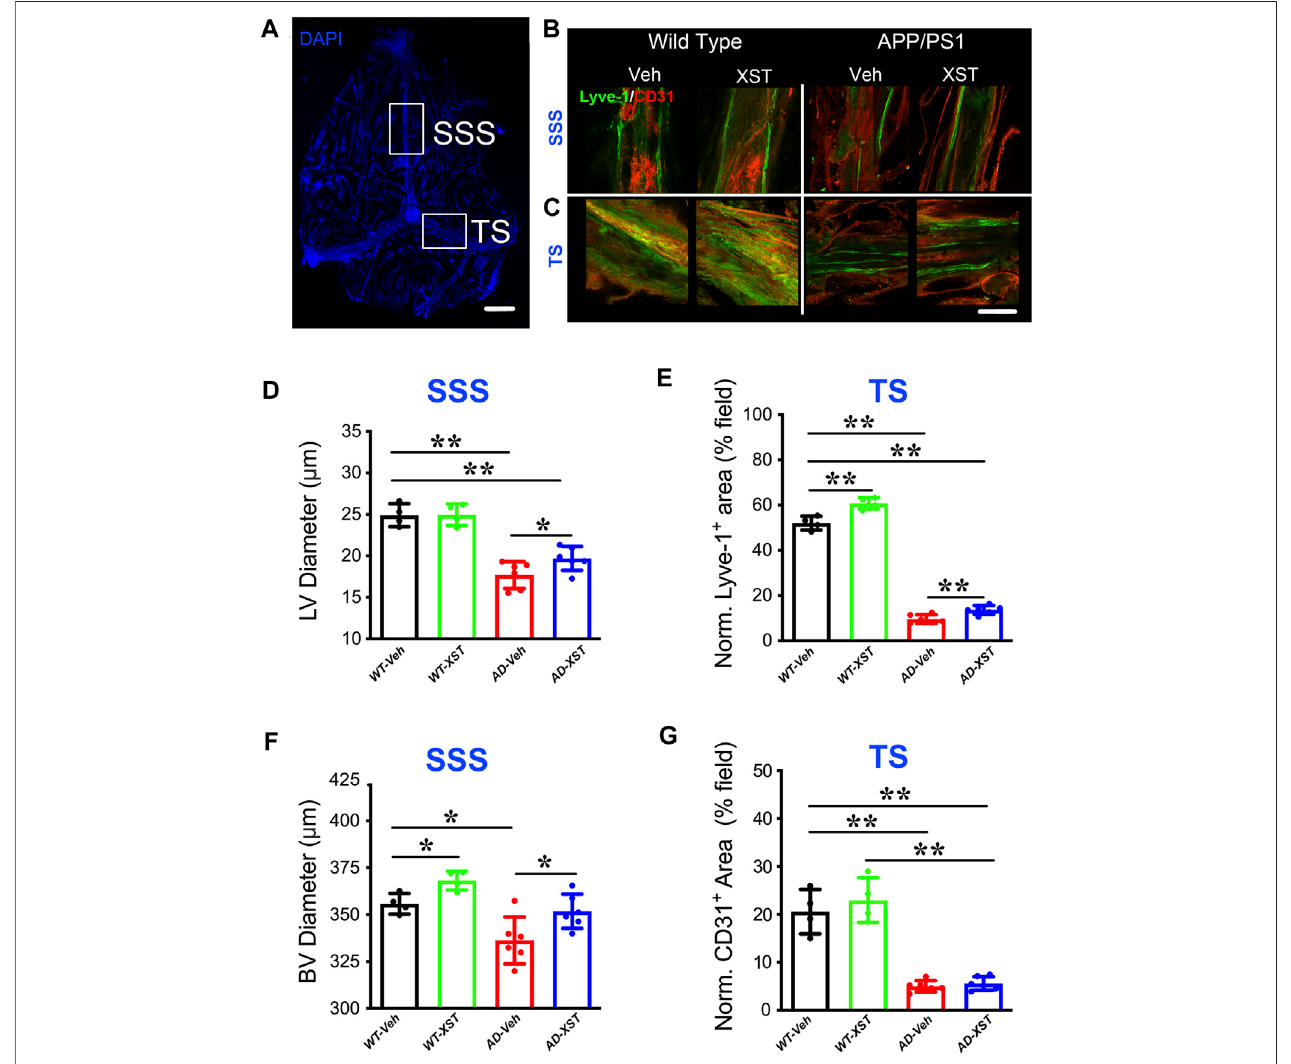
FIGURE1| EffectsofXSTonlymphaticstructures. (A) Schematicrepresentationofthewhole-mountdissectionoftheduramater.SSS,superiorsagittalsinus;TS, transverse sinus. Scale bar, 2,000 μ m. (B) Sample images of lymphatic vessels (LVs) (Lyve-1) and blood vessels (BVs) (CD31) in the SSS region, in wild-type and APP/ PS1micetreatedwitheitherXSTorVehicle(Veh).C57-Veh( n (cid:2) 4mice),C57-XST( n (cid:2) 4mice),AD-Veh( n (cid:2) 6mice),AD-XST( n (cid:2) 6mice).Scalebar,200 μ m. (C) Sample images of lymphatic ducts (Lyve-1) and BVs (CD31) in the TS region, in wild-type and APP/PS1 mice treated with either XST or Veh. Scale bar, 200 μ m. (D) Quanti fi cation of the diameter of lymphatic ducts in mice treated with XST or Veh in the SSS region (F (1, 16) (cid:2) 87.18, C57 vs. AD, p < 0.0001; AD-Veh vs. AD-XST, p (cid:2) 0.034, two-way ANOVA with Bonferroni ’ s multiple comparisons). (E) Quanti fi cation of the area occupied by lymphatic ducts in mice treated with XST or Veh in the TS region (F (1, 16) (cid:2) 36.92, C57 vs. AD, p < 0.0001; C57-Veh vs. C57-XST, p < 0.001; AD-Veh vs. AD-XST, p (cid:2) 0.0454, two-way ANOVA with Bonferroni ’ s multiple comparisons). (F) Quanti fi cationofthediameterofBVsinmicetreatedwithXSTorVehintheSSSregion(F (1,16) (cid:2) 22.18,C57vs.AD, p (cid:2) 0.0002;C57-Vehvs.C57-XST, p (cid:2) 0.049;AD-Vehvs.AD-XST, p (cid:2) 0.0303,two-wayANOVAwithBonferroni ’ smultiplecomparisons). (G) Quanti fi cationoftheareaoccupiedbyBVsinmicetreatedwith XST or Veh in the TS region (F (1, 16) (cid:2) 141.4, C57 vs. AD, p < 0.0001; two-way ANOVA with Bonferroni ’ s multiple comparisons). Data are mean ± SEM. * p < 0.05; ** p <